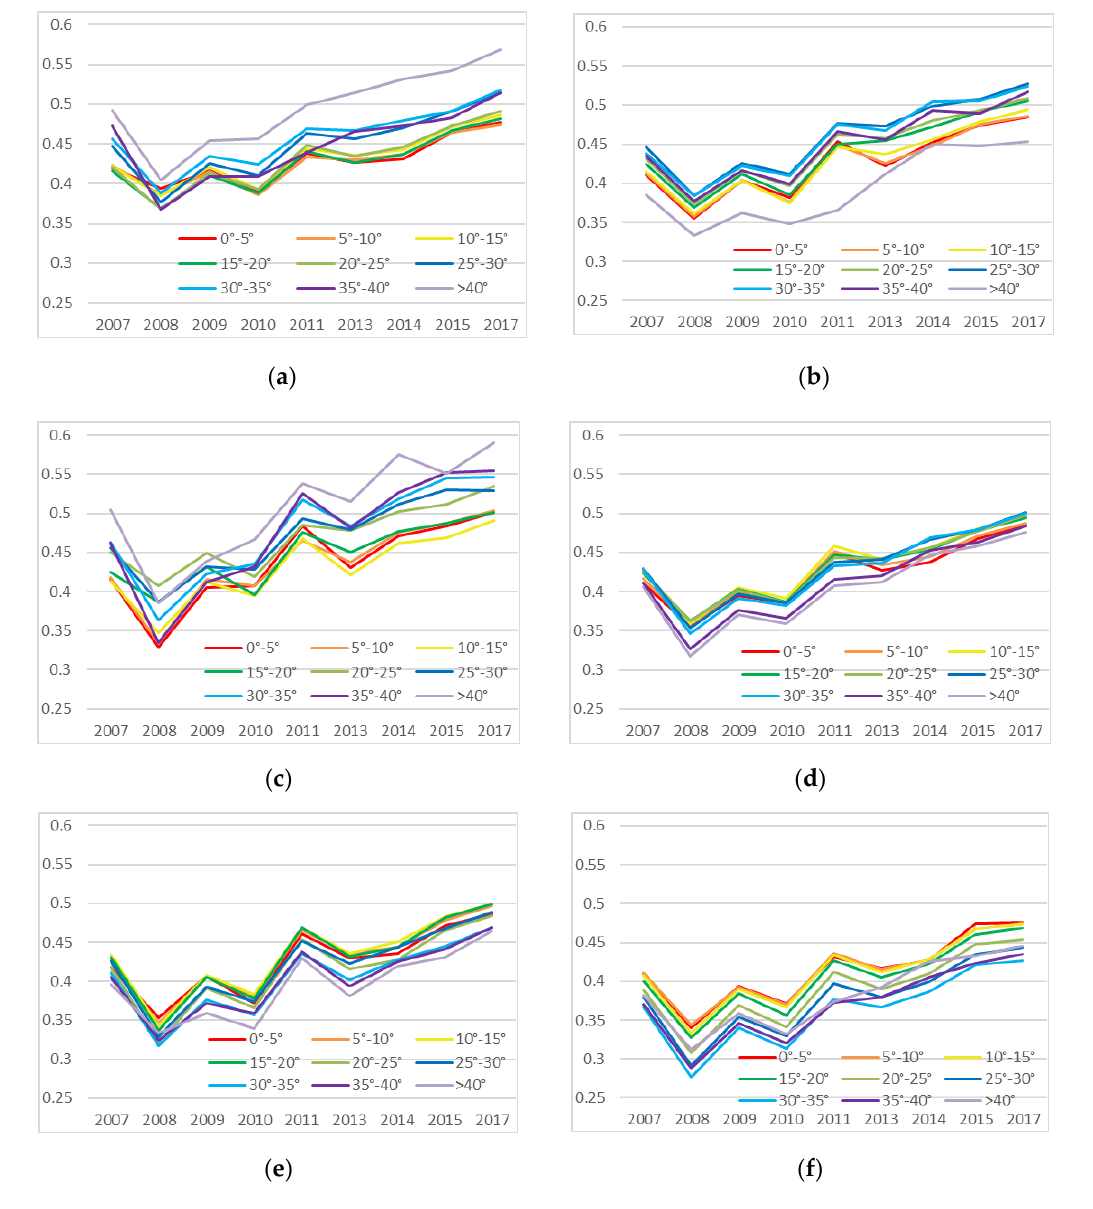
Table 15. Post-disaster recovery and fluctuation-degree-analysis results for six forest types in different slope zones.